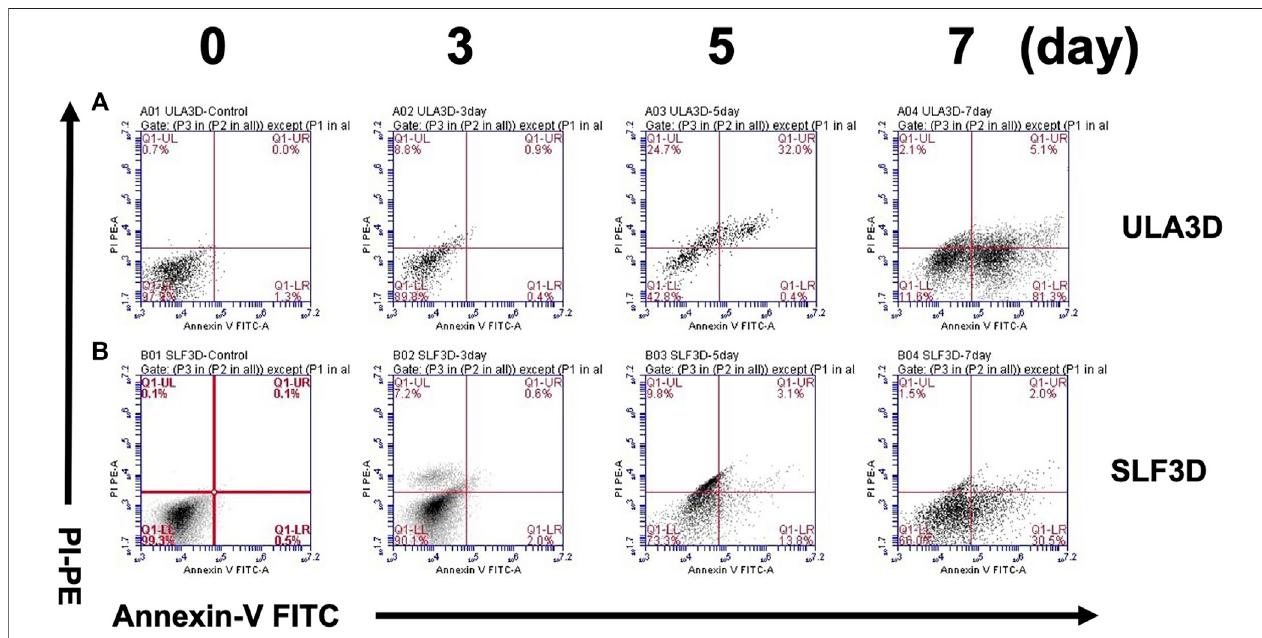
FIGURE 6 | SLF-3D and ULA-3D spheroid cell viability was evaluated by fl ow cytometry. Viability of cells in the SLF-3D and ULA-3D spheroids. (A,B) Viability of ASCs as determined by fl ow cytometry measuring PIuptakeand annexin V-FITC labeling. Representative log fl uorescent dot plots and summary of the data are shown. As in the fi gure, 0, 3, 5ays, and 7 days indicate the number of days of cell culture. Cell populations were distinguished as live cells (PI-/annexinV-, lower left), or necrotic/ dead/apoptotic cells (early apoptotic cells (PI − /Annexin V+), shown in the lower right; late apoptotic/dead cells (PI+/Annexin V+), shown in the upper right, and necrotic cells (PI+/Annexin V − ), shown in the upper left. Three independent experiments were performed in duplicate, and representative results are shown. Data were acquired using BD Accuri C6 software.